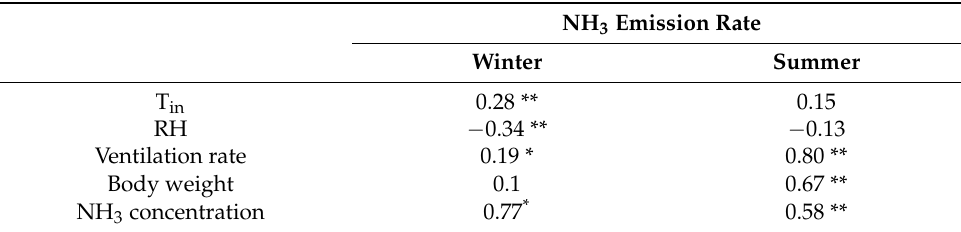
Table 3. Correlations between ammonia emission and environmental parameters.